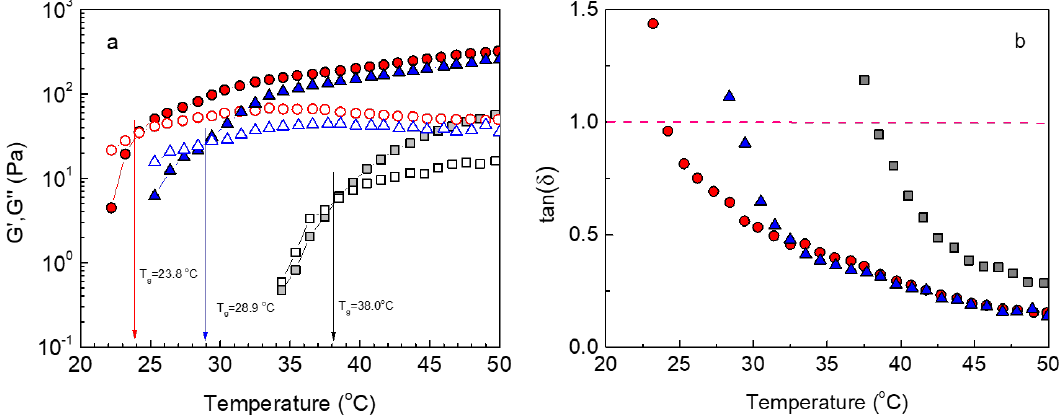
Figure 3. Temperature dependence of G′ (closed symbols), G″ (open symbols) ( a ), and tanδ ( b ) at 1 Hz, strain amplitude of 0.1% and heating ramp of 1 °C/min for the hydrogels formed by ALG-g- P(NIPAM 86 - co -NtBAM 14 ) (circles), ALG/HGC (triangles) and ALG-g-P(NIPAM) (squares) gelators. The arrows in ( a ) indicate T gel and the dashed line in ( b ) denotes the sol/gel point (tanδ = 1).